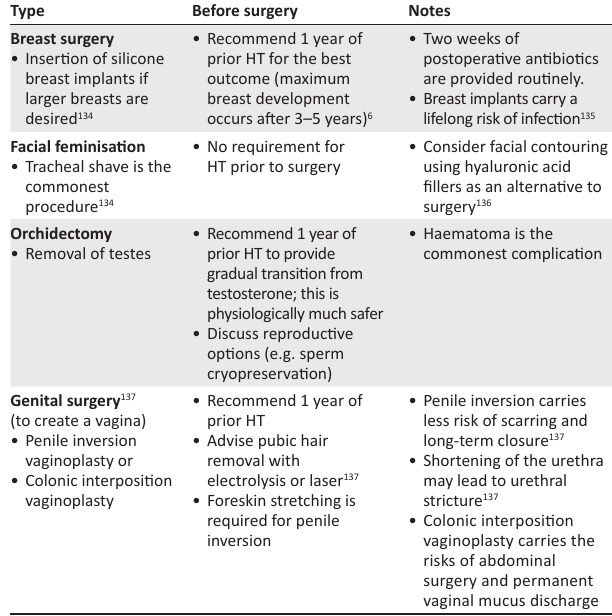
TABLE 9: Feminising surgery.